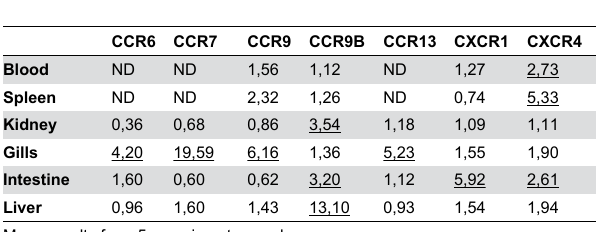
Table 2. Ratio of chemokine receptor transcription in IgM + cells in comparison to levels detected in the corresponding negative fractions (IgM + : IgM -